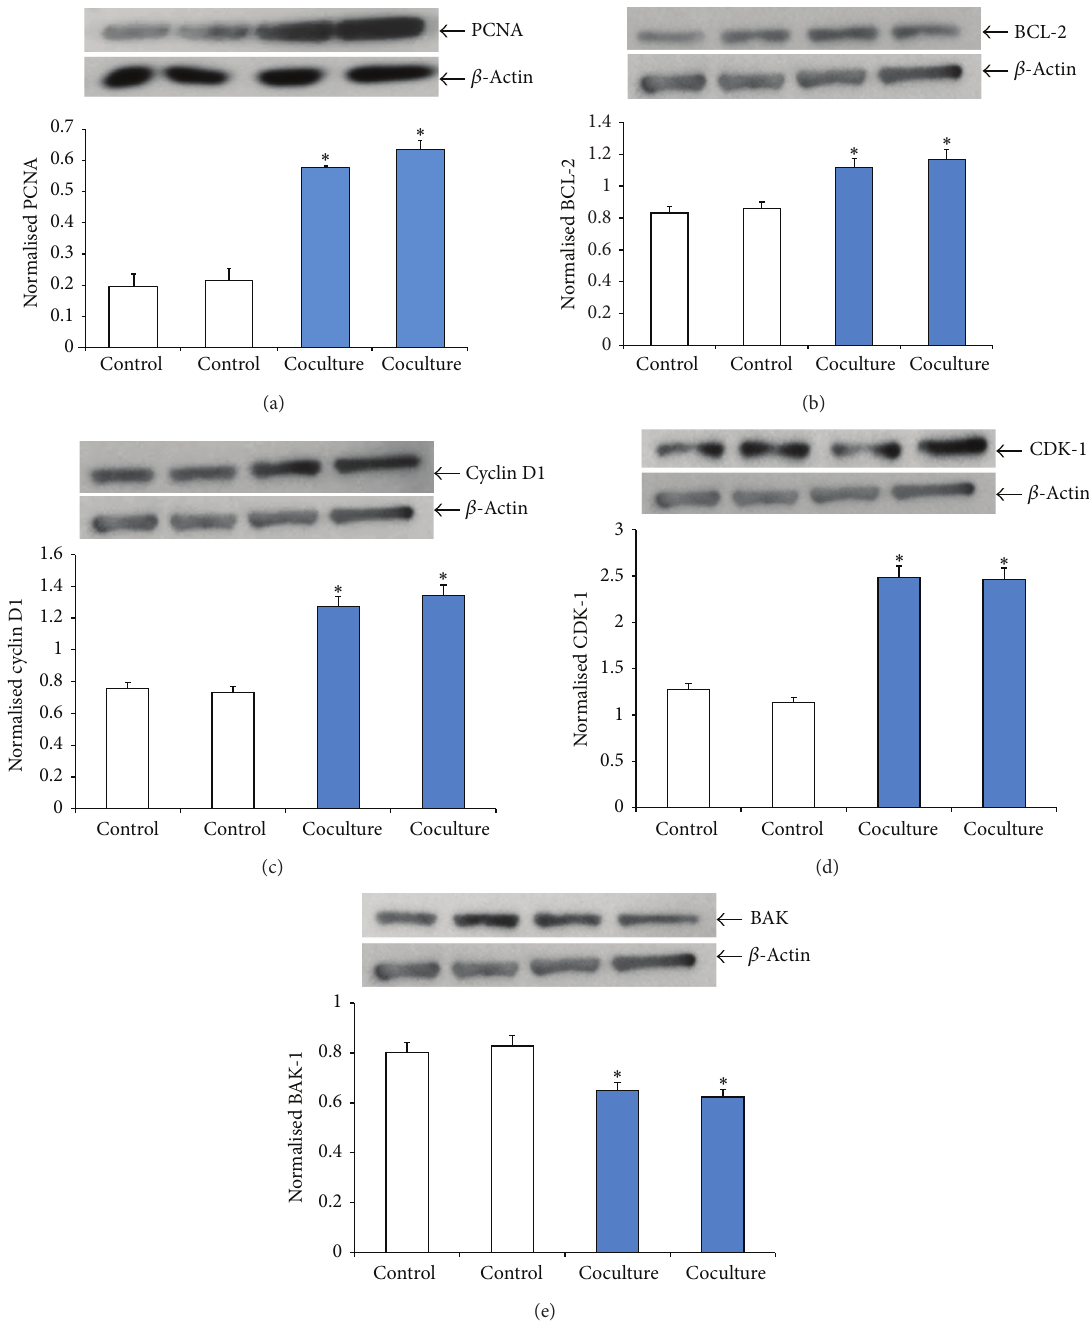
Figure 3: Western blot analysis of PCNA, BCL-2, cyclin D1, CDK-1, and BAK in EGE cells with and without coculture. EGE and SW872 cells were in coculture for 6 days. Lysates prepared from control and cocultured cells were analyzed by Western blotting with (a) anti-PCNA, (b) anti-BCL-2,(c)anticyclinD1,(d)anti-CDK-1,and(e)anti-BAKantibodies.Theintensityofeachproteinsignalwasquantifiedandnormalized with corresponding 𝛽 -actin. Results shown represent three separate experiments with comparable results. ∗ 𝑃 < 0.05 compared with